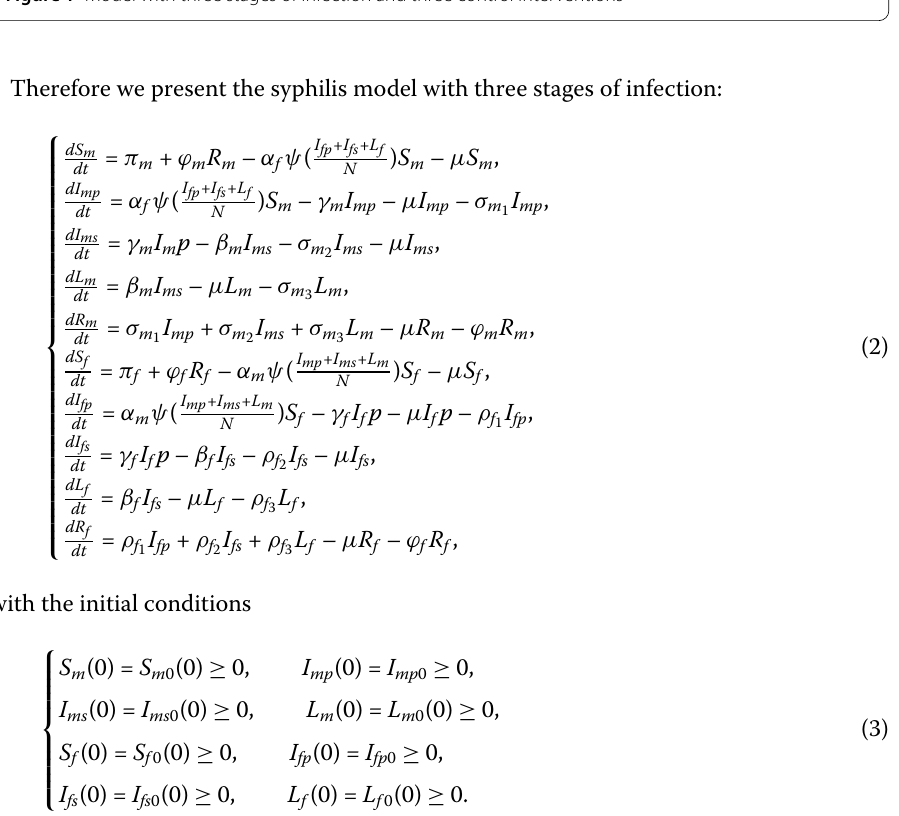
Figure 1 Model with three stages of infection and three control